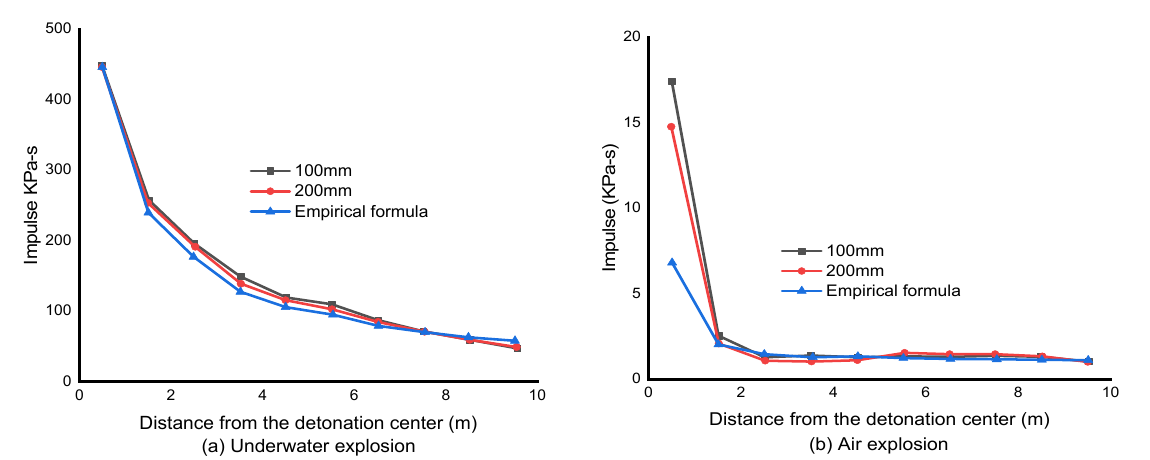
Figure 9. Mesh size effect of a shock wave impulse.